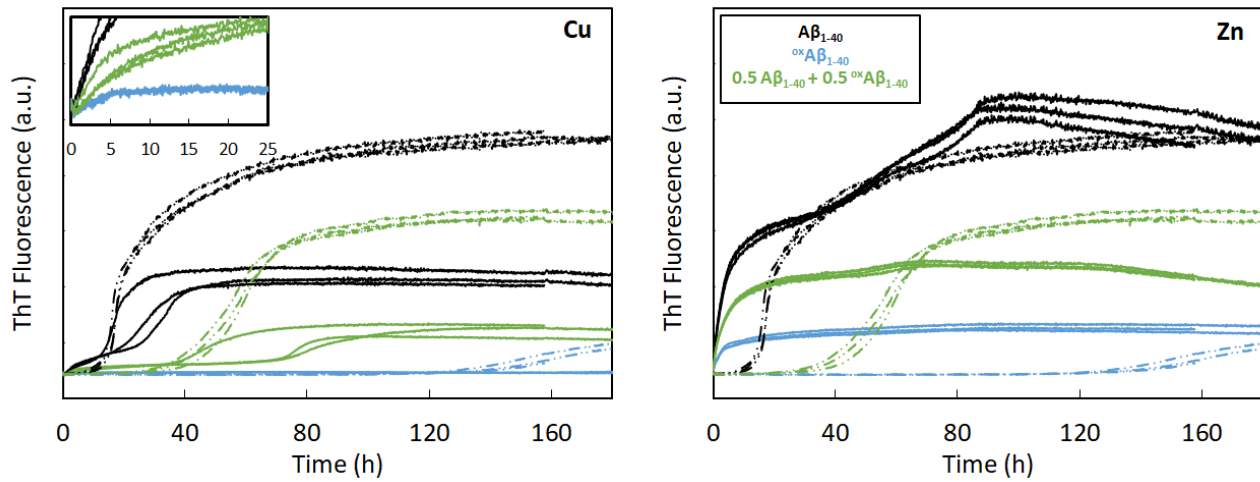
Figure 6. Kinetic monitoring of A β 1–40 and ox A β 1–40 co-assembly in presence of Cu(II) or Zn(II) using ThT fluorescence. Curves are shown as triplicate. [A β 1–40 ] = 20 µM (black); [A β 1–40 ] = [ ox A β 1–40 ] = 10 µM (green); [ ox A β 1–40 ] = 20 µM (blue). Apo peptides (dashed curves) with Cu(II) (18 µM, solid curves, left panel) or Zn(II) (18 µM, solid curves, right panel) at pH 7.4. Data from Experiment N°1: HEPES buffer 50 mM, NaCl 65 mM. Y-axis corresponds to ThT fluorescence in arbitrary unit (a.u.); data are directly comparable between them (same y-scale).